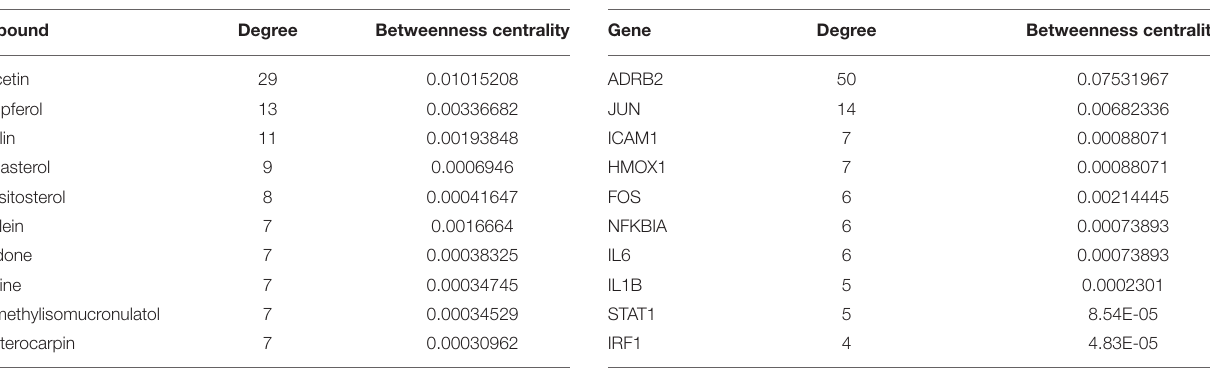
TABLE 1 | The top 10 key compounds in FPQXZ. TABLE 2 | The top 10 core targets in